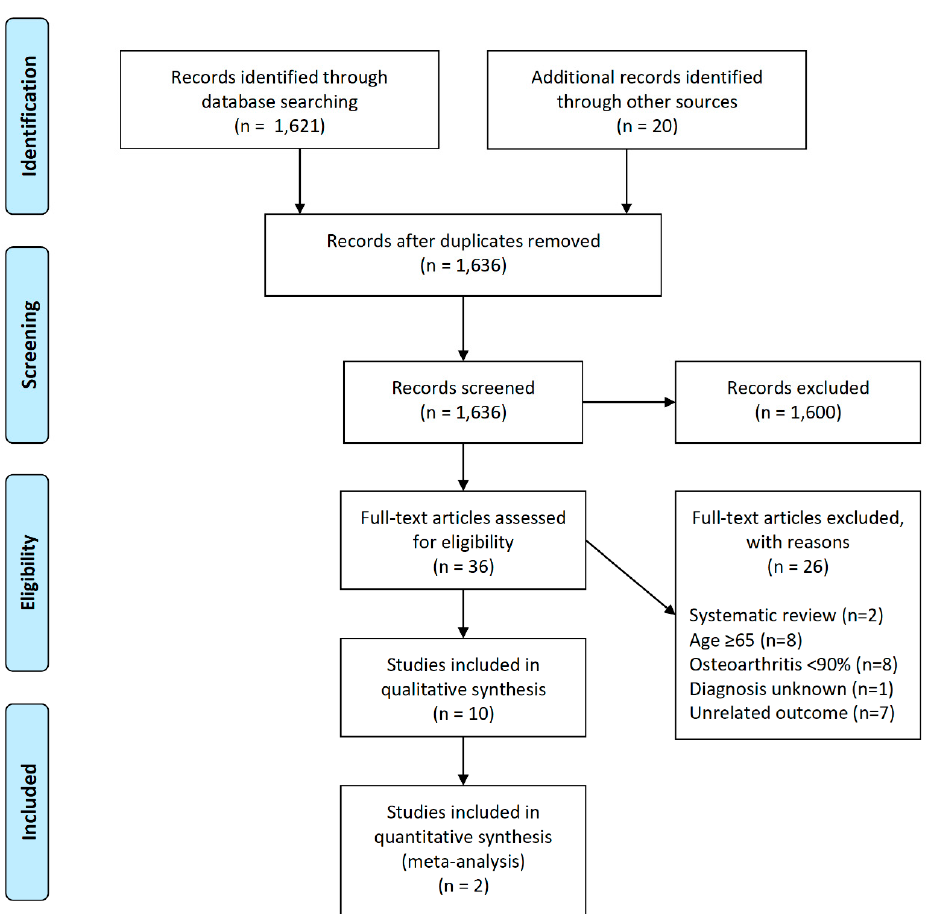
Figure 1. Preferred Reporting Items for Systematic Reviews and Meta-Analyses (PRISMA) flow diagram of search algorithm.